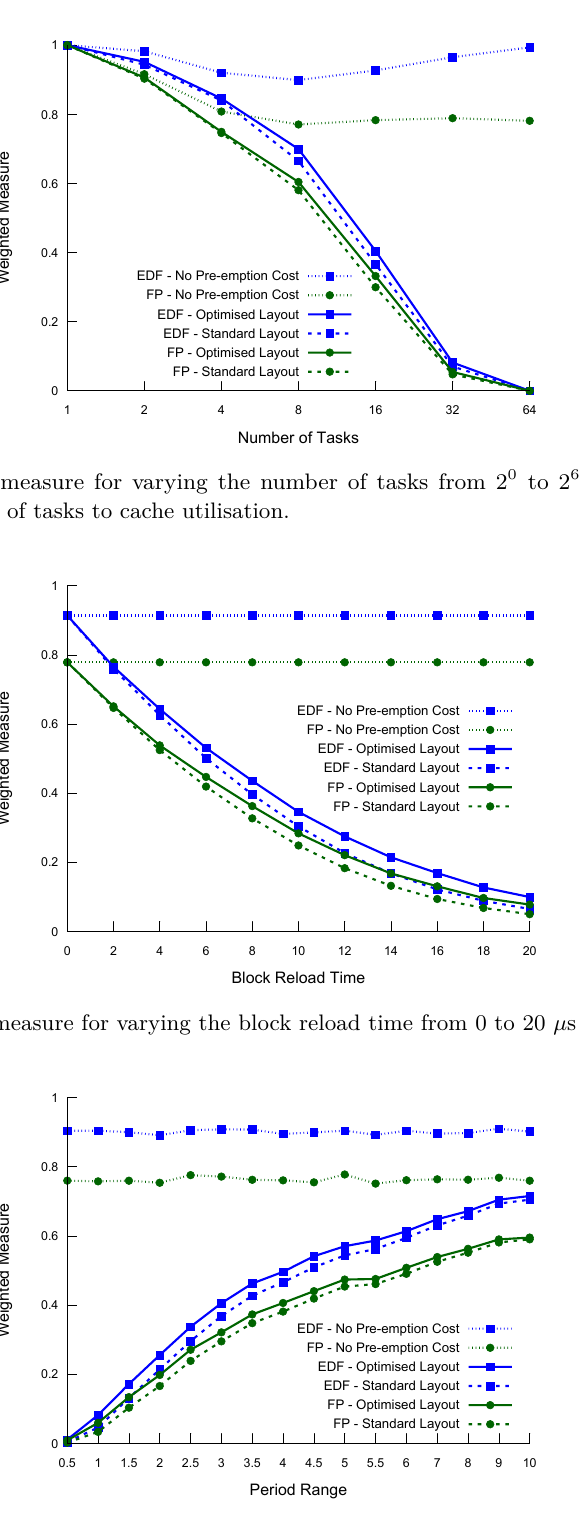
Figure 14 Weighted measure for varying the scaling factor used to generate periods, w , in w [1, 100] ms, from 0.5 to